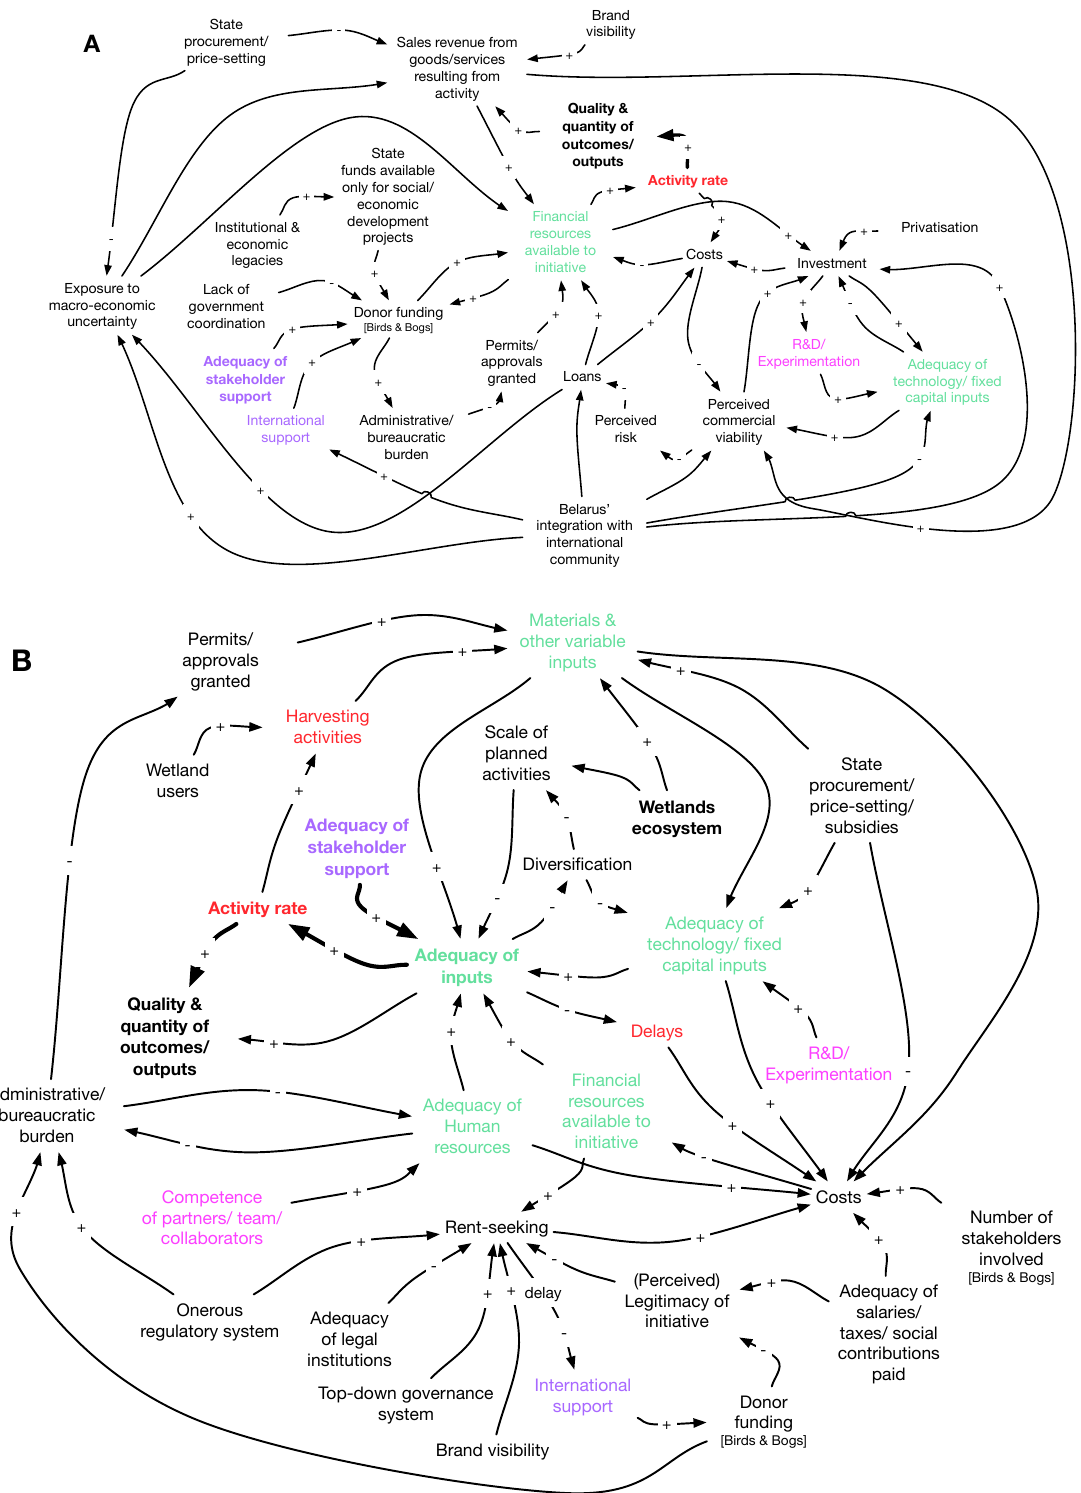
Figure 7A & B (from main paper). Sub-models unpacking causal dynamics influencing Adequacy of inputs for wetland restoration initiatives. Inputs are disaggregated into four main types: Financial resources, Technology/ fixed capital, Human resources, and Materials and other variable inputs. Fig. 7 is separated into two sub-models simply to reduce diagrammatic complexity and aid reader comprehension. Links from support to the various disaggregated types of inputs are aggregated into one main link in